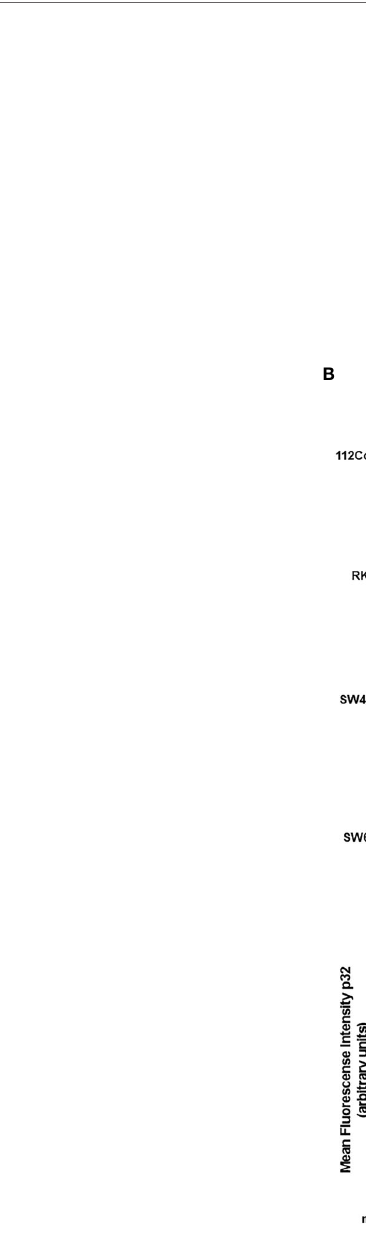
FIGURE 1 | p32 protein is overexpressed in malignant colon cells relative to non-malignant cells. (A) The expression of p32 was evaluated in colon non-malignant 112CoN and colon malignant RKO, SW480, and SW620 cells by Western blot. Actin was used as a control for equal loading. Densitometric analysis was performed to quantify the change in p32 expression levels. The data is presented as the mean values ± SEM from at least three independent experiments, *p < 0.05, **p < 0.01. (B) 112CoN, RKO, SW480, and SW620 cells were fi xed with 1% PFA and permeabilized with 0.3% Triton X-100. The intracellular expression of p32 was examined by immuno fl uorescence confocal microscopy. p32 nuclear expression was assessed by merge analysis between the p32 and DAPI signals. Scale bar, 10 m m. Representative images from 3 independent experiments are shown. The quanti fi cation of p32 expression levels in 112CoN, RKO, SW480, and SW620 cells, measured by mean fl uorescence intensity in arbitrary units from analysis of immuno fl uorescence confocal microscopy images, is also shown. The data is presented as the mean values ± SEM from at least three independent experiments, *p < 0.05, **p < 0.01, ***p <